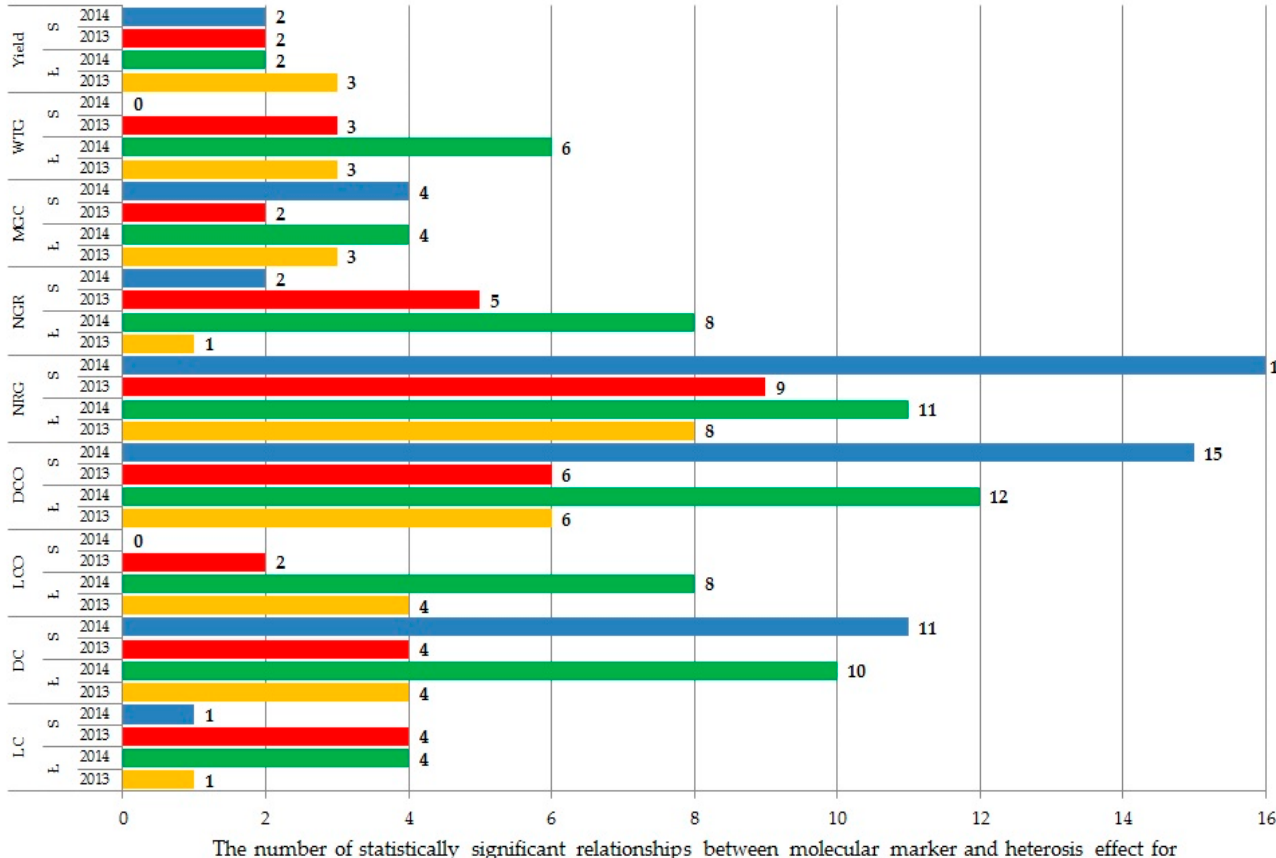
Figure 3. The number of statistically signi fi cant relationships between the molecular marker and heterosis effect for particular traits in studied environments. LC—cob length, DC—cob diameter, LCO—core length, DCO—core diameter, NRG—the number of rows of grain, NGR—the number of grains in a row, MGC—mass of grain from the cob, WTGs—weight of 1000 grains, Ł—Łagiewniki, S—Smolice.